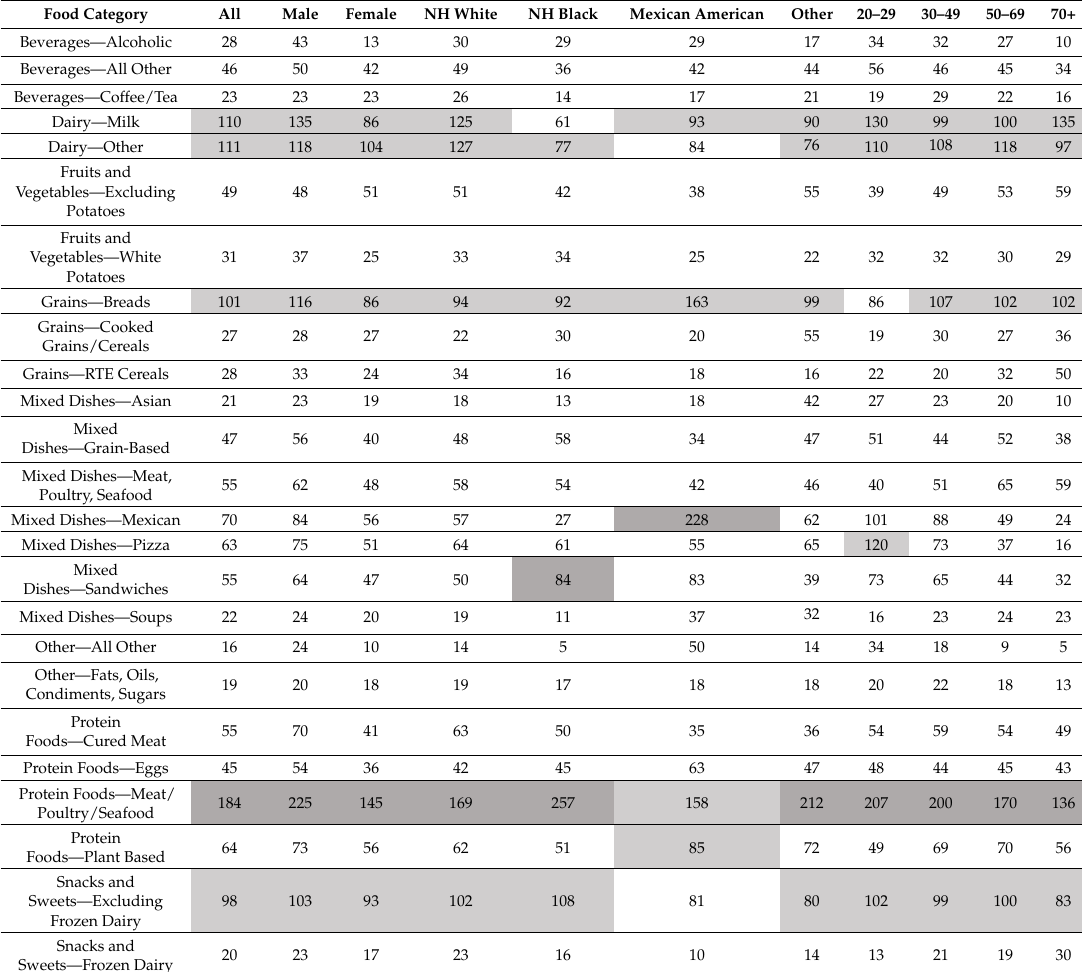
Dark grey shading indicates highest single contributor, light grey shading indicates one of the top 5 contributors. NH = Non-Hispanic.